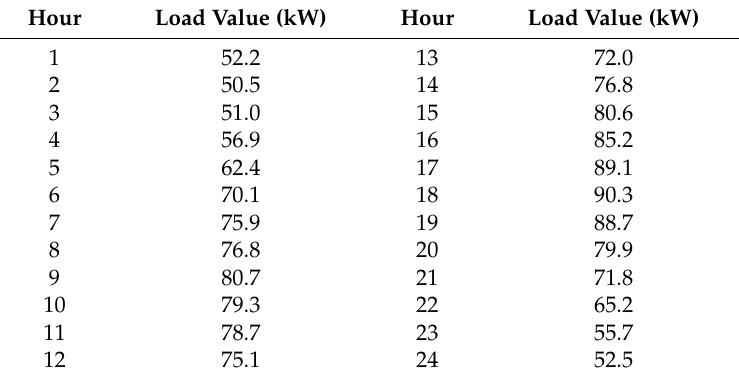
Table 2. Average MG hourly load